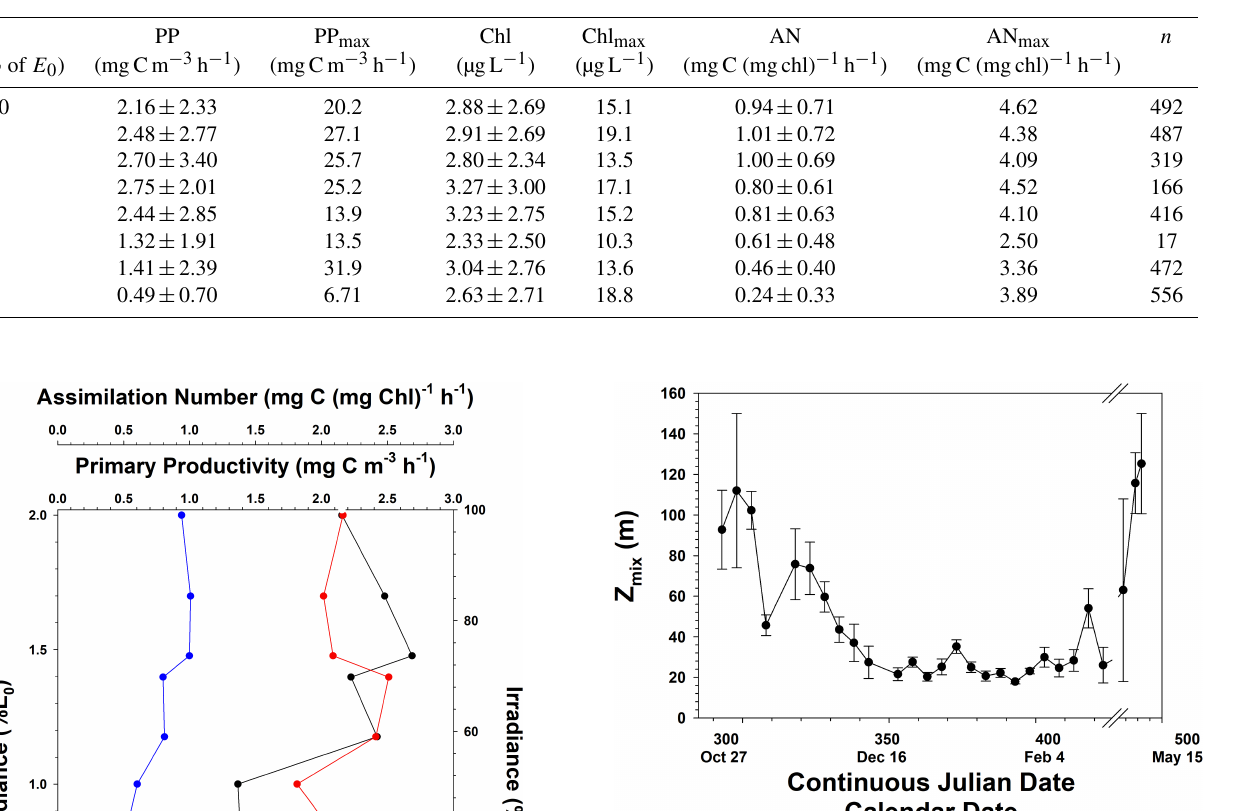
Table 3. Mean and standard deviation, maximum observed, and number of measurements of primary productivity (PP), chlorophyll concen- tration (Chl), and assimilation number (AN) within the euphotic zone of the Ross Sea. E = percentage of surface irradiance; E 0 = surface irradiance; PP max = maximum rate of productivity at that isolume; Chl max = maximum chlorophyll concentration at that isolume; AN max = maximum assimilation number at that isolume; n = number of observations. Daily photosynthetically active radiation values for each station are available in the publicly available data set.